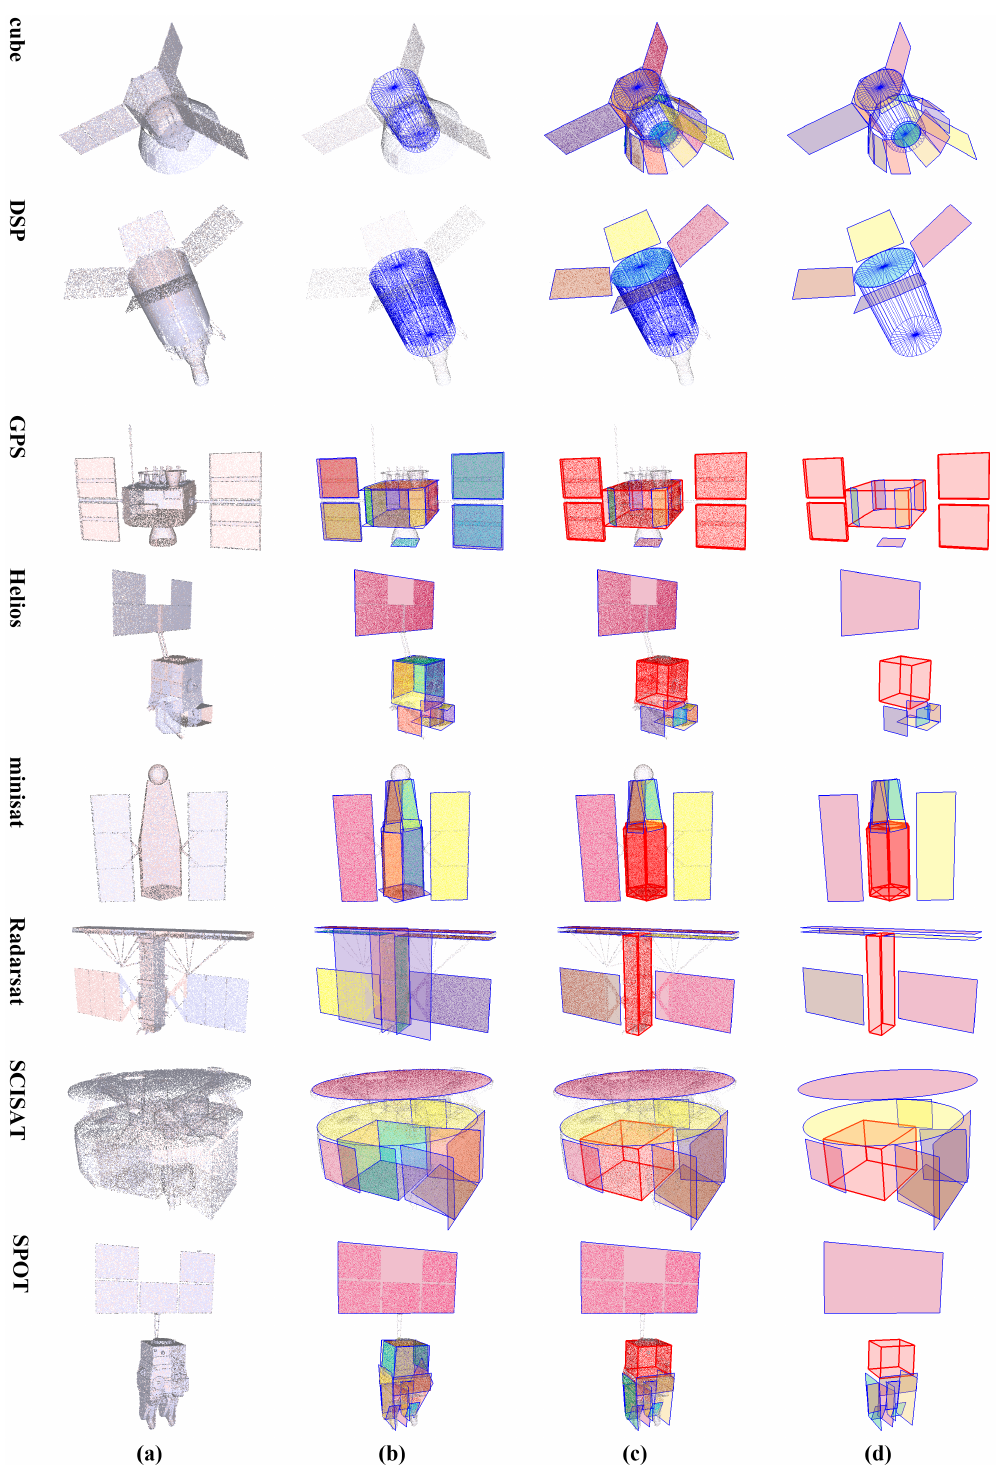
Figure 4. Detection results of the synthesized point cloud data 50K_00U_00D . From left to right: ( a ) the origin input point clouds; ( b ) results of cylinder detection or patch detection after detection of cylinders (the cylinders are rendered in blue, and patches are rendered in different colors.); ( c ) final results (the detected cuboids are rendered as red boxes.); ( d ) a clear view of the detected